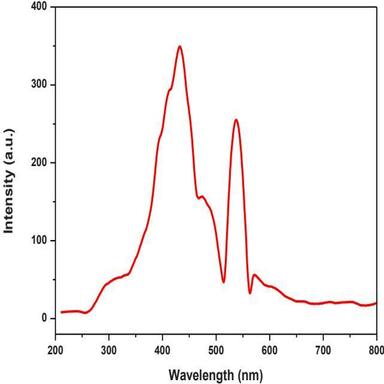
photoluminescent graph of MTZ - ZnMoO4 nanocomposite.